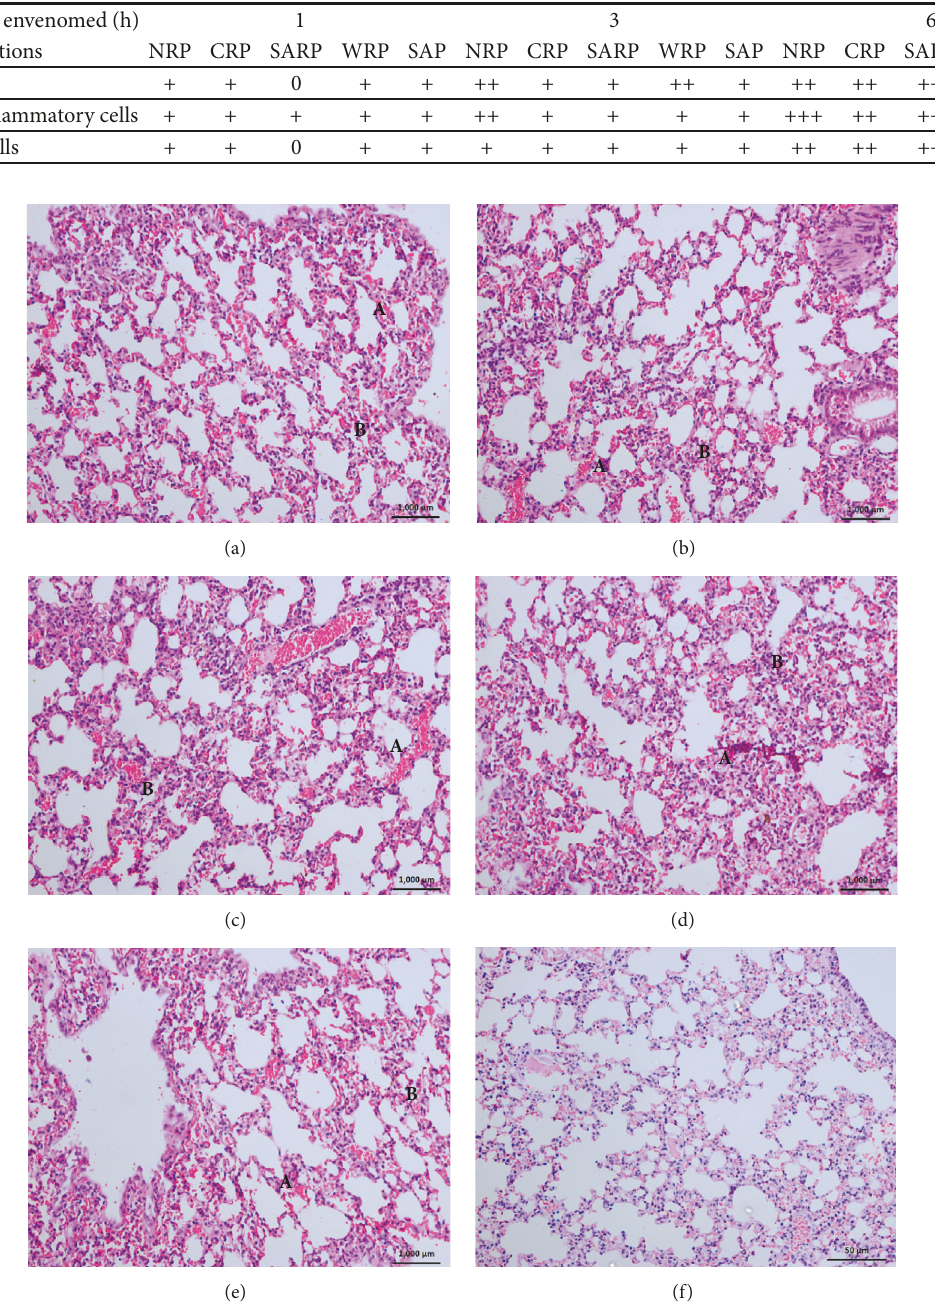
Figure 4: Histopathological changes in lung tissues, after 3hr from injection of N. naja venom from (a) Western Region Population, (b) Central Region Population, (c) North Region Population, (d) Sabaragamuwa Region Population, (e) Southern Region Population, and (f) Control. (A) Alveolar haemorrhages. (B) Interstitial septal widening.